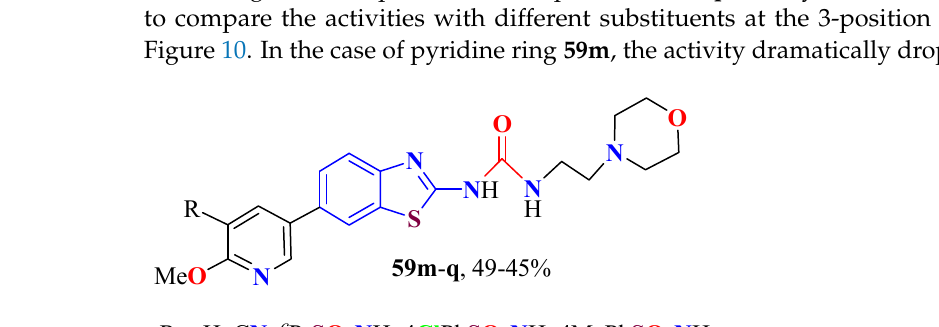
Figure 10. The 6-(2-Ome, 3-substituted Pyridine 2-morpholinethylUBTs for comparative activities. The 6-sulfonamide-2ABT was reacted with one equivalent of carbon disulfide and one or two equivalents of dimethyl sulfate in the presence of one equivalent or two equiv- alents of sodium hydroxide to afford compounds 60 in 54% and 62 in 67%, Scheme 20. Furthermore, compound 60 was reacted with ethylenediamine or piperazine in dioxane at room temperature to give the bis-TBTs 61a or 61b , in 21 and 20.7%, respectively. Under the same reaction conditions, compound 62 produced the bis-Methyl-iso-TBTs 63a or 63b in 14 and 17%, respectively [149]. All compounds were investigated as inhibitors of the four isoforms of the metalloenzyme carbonic anhydrase (CA, EC 4.2.1.1), the cytosolic CA I and II, and the tumor-associated isozymes CA IX and XII. Docking studies showed fa- vorable interactions between the scaffolds of these new inhibitors and the active sites of the investigated CA isoforms. Compounds 61a , b and 63a , b acted as highly potent inhibi- tors of the tumor-associated hCA IX and hCA XII with K I s in the nanomolar range (2.1– 2.6 and 4.3–4.8 nM), compared to the standard drugs AAZ (25 and 5.8 nM) and EZA (34 and 22 nM). The cytosolic isozyme hCA II was also inhibited with K I s ranging from 3.5 to 4.7 nM, compared with the standard drugs (12 and 8 nM). On the other hand, from mo- lecular docking studies, compounds 61a,b and 63a,b were found as potent inhibitors against the slow cytosolic isoform hCA I with K Is in the range of 12.0–37.4 nM, compared to the standard drugs (250 and 25 nM).